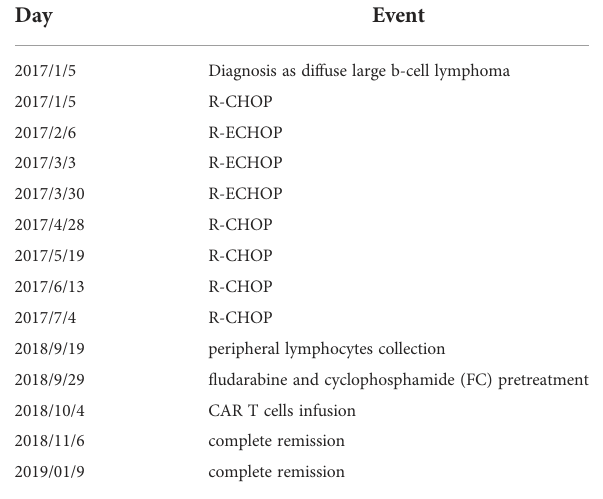
TABLE 4 Timeline of patient 2.